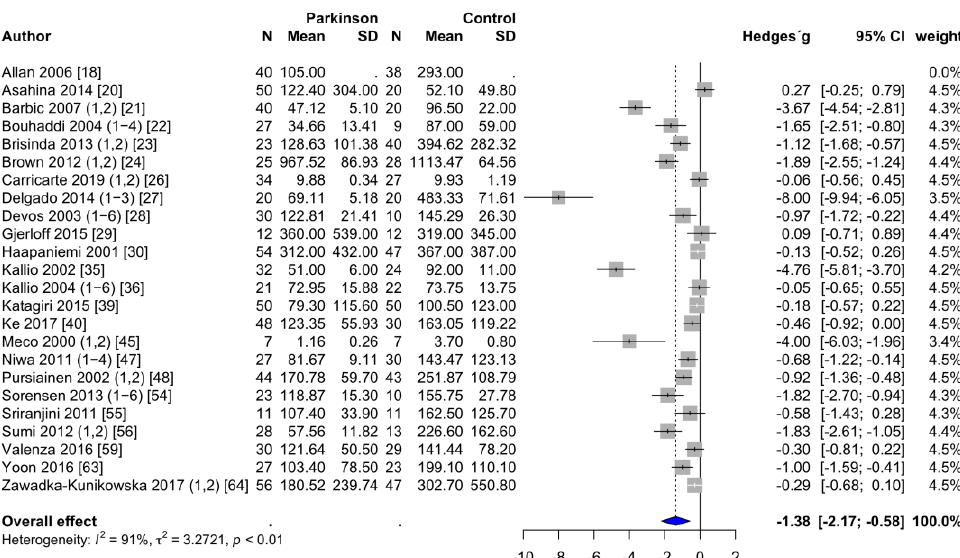
Figure 2. Forest plot HFms 2 , random-effects meta-analysis. HFms 2 : high-frequency components of the power spectral density in ms 2 ; N: number; SD: standard deviation; CI: confidence interval. Rhombus indicates meta-analytically pooled estimate of the 95% confidence interval. The numbers after the authors indicate the included substudies according to the information provided in Appendix A, Table A1.